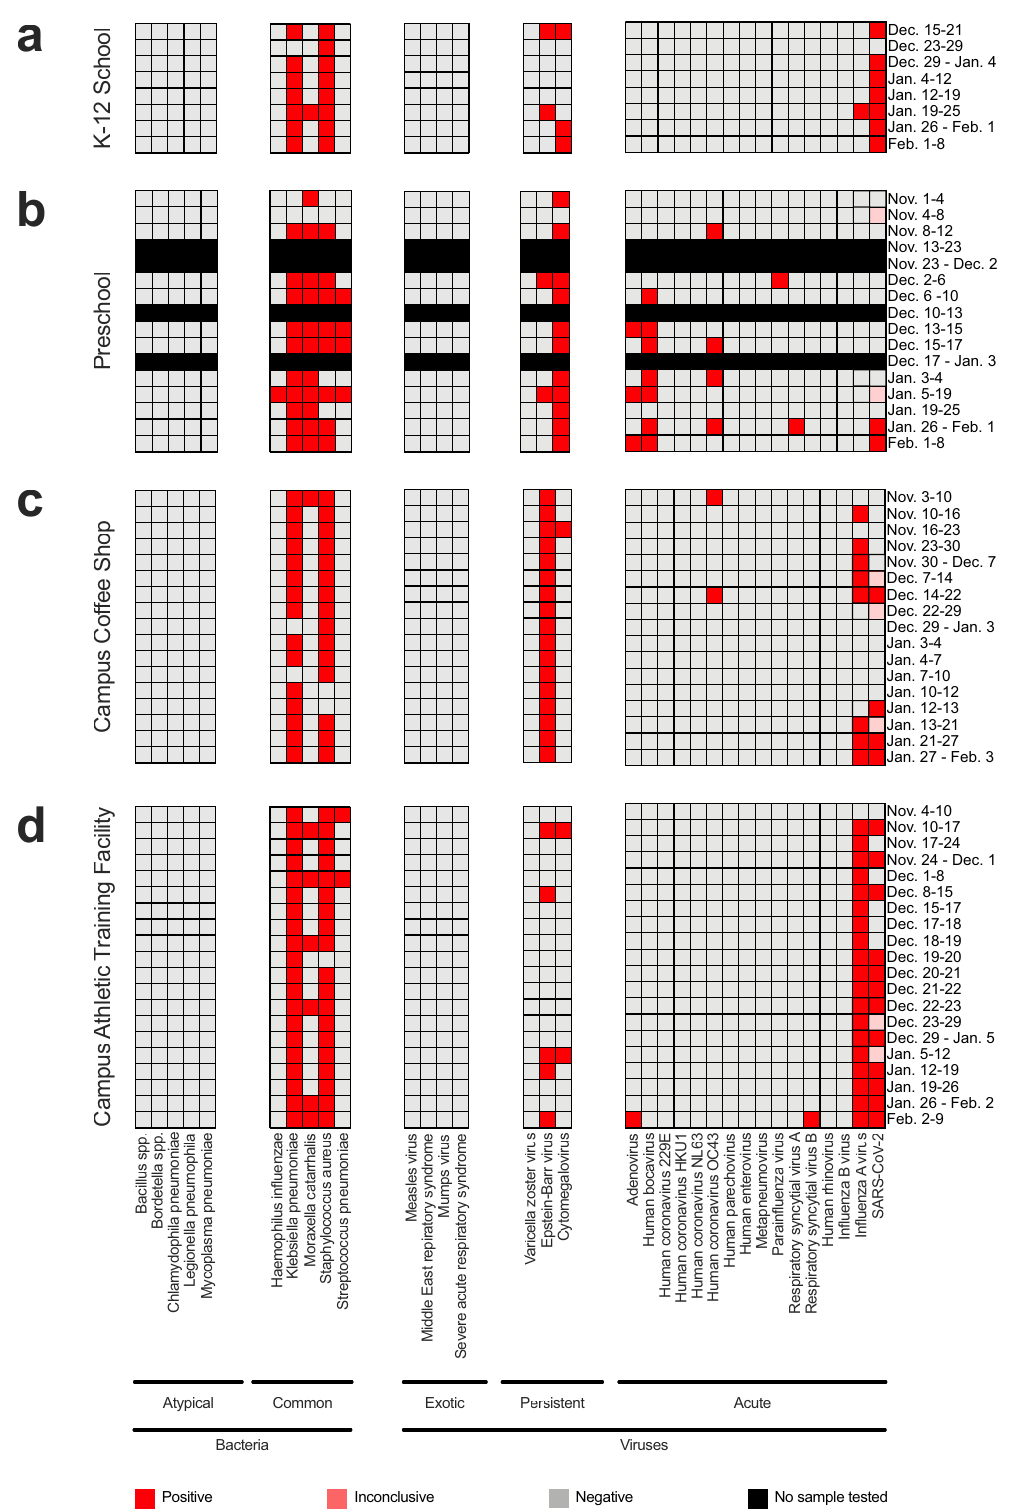
Fig. 3 | In-air respiratory pathogen detection in congregate settings. a Respiratory pathogen detection in air samples collected from a K-12 school, b preschool, c campus coffee shop, and d campus athletic facility. Genomic materialfrom 40respiratorypathogenswasdetected bysemi-quantitative RT-PCR using the TrueMark Respiratory 2.0 TaqMan Array Card. SARS-CoV-2 genomic